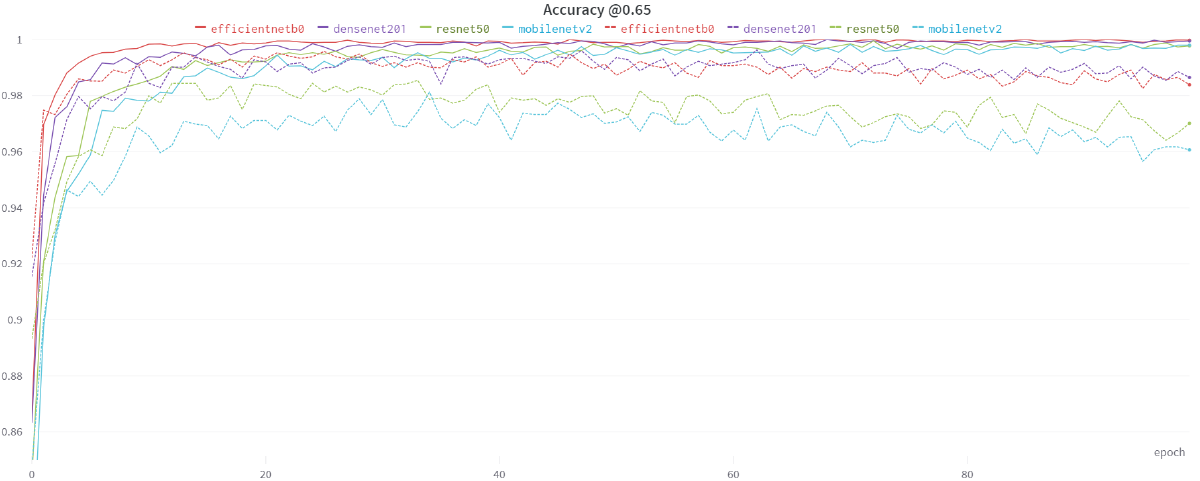
Figure 13. Comparison of the accuracy among ResNet50, DenseNet, MobileNetV2, and EfficientNet- B0 with a threshold score of 0.65.